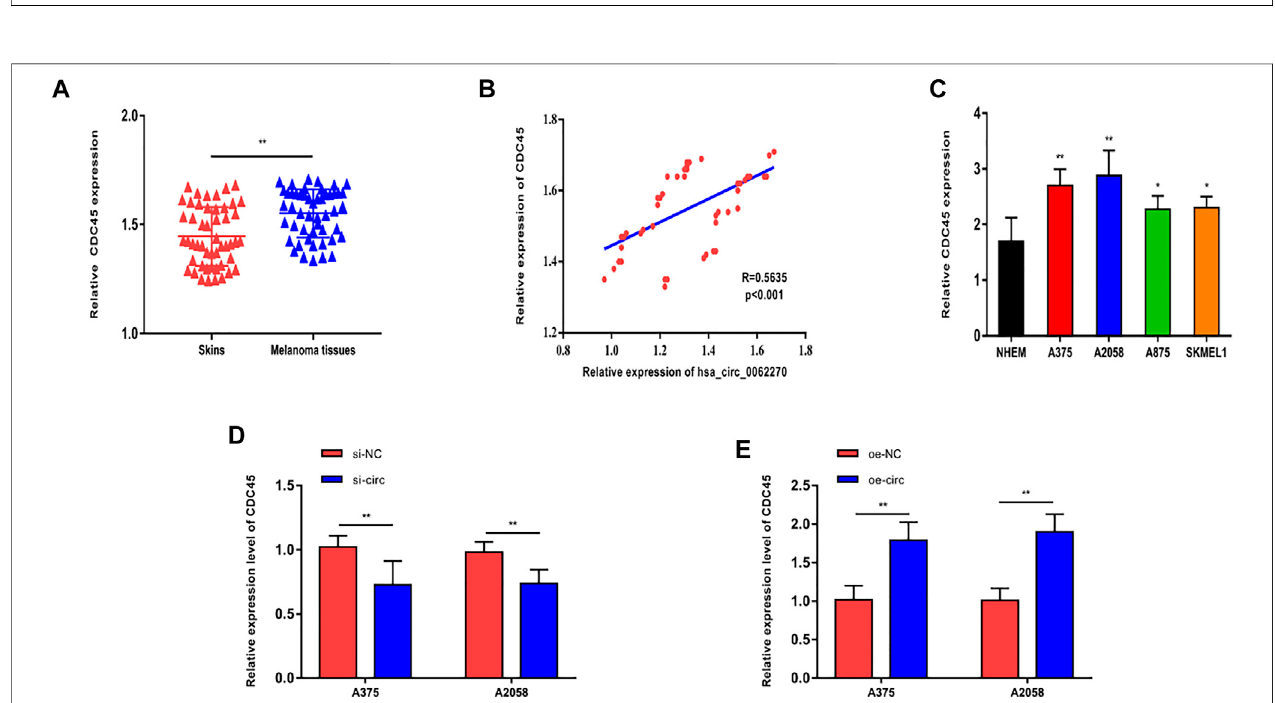
FIGURE 3 | hsa_circ_0062270 stabilized CDC45 expression. (A) Differential level of CDC45 in melanoma and normal skin tissues; (B) A positive correlation between hsa_circ_0062270 and CDC45 levels in melanoma tissues; (C) Differential level of CDC45 in melanoma cells and normal human epidermal melanocytes; (D) CDC45 in cells with hsa_circ_0062270 knockdown; (E) CDC45 in cells overexpressing hsa_circ_0062270. * p < 0.05; ** p < 0.01.